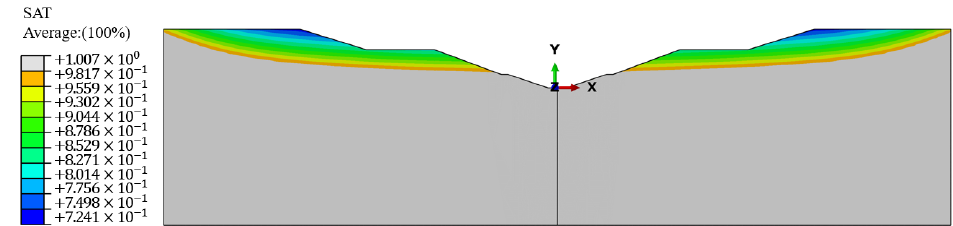
Figure 9. Canal saturation contour when t = 20 years.